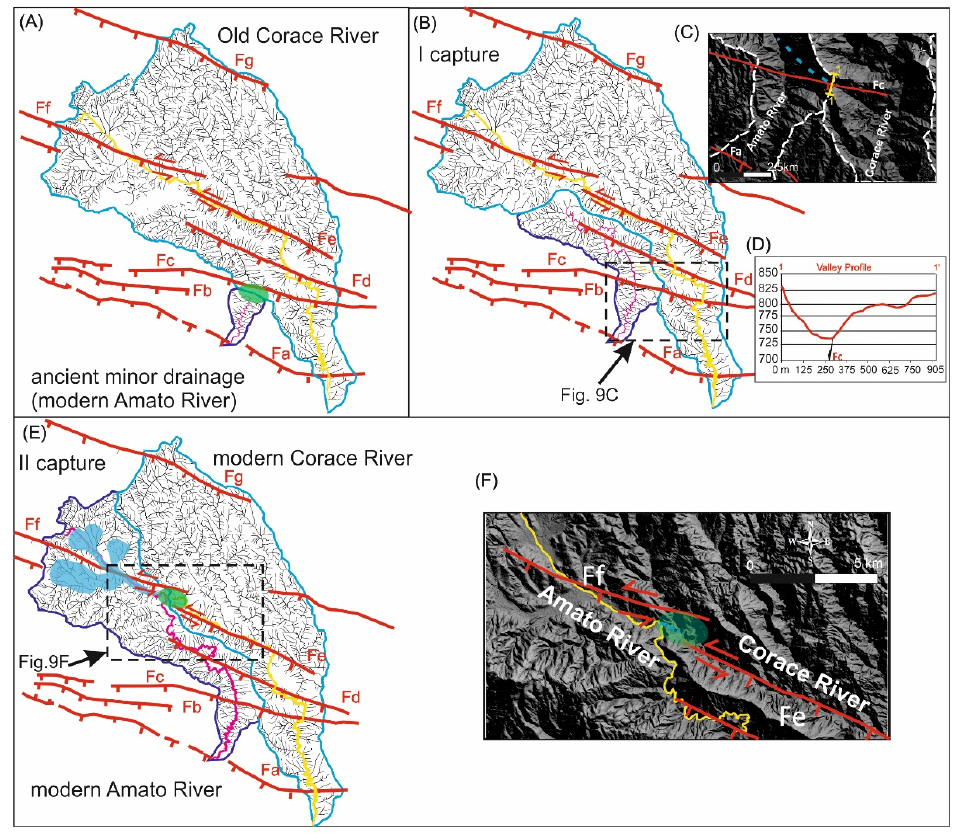
Figure 9. Reconstruction of the evolution of the fluvial network of Am4 sub-basin (blue polygon is the watershed, the pink line is the main river course) and fluvial network of C2 sub-basin (cyan polygon is the watershed, the yellow line is the main river course). ( A ) Ancient Am4 fluvial network (blue polygon), initially formed by minor drainage, and ancient C2 fluvial network (cyan polygon); the green ellipse indicates the zone of the fluvial catchment. ( B ) Fluvial network configuration after the first capture of the minor drainage (old Am4 fluvial network) at the expense of the old C2 fluvial network. ( C ) Detail of the fluvial capture of the old C2 fluvial network (see Figure 9B for location); blue dashed line is the track of the suspended valley. ( D ) Profile of the watershed (see the yellow trace 1-1 ′ in Figure 9C) showing the suspended valley and the track of Fc. ( E ) Second capture of the old C2 fluvial network and present-day configuration of the two rivers; green ellipse is the area of push-up and obstruction of the old C2 fluvial network; cyan polygon represents the Decollatura paleolake. ( F ) Detail of the northern capture; the cyan line inside the green ellipse is the old abandoned C2 drainage (see Figure 9E for location).